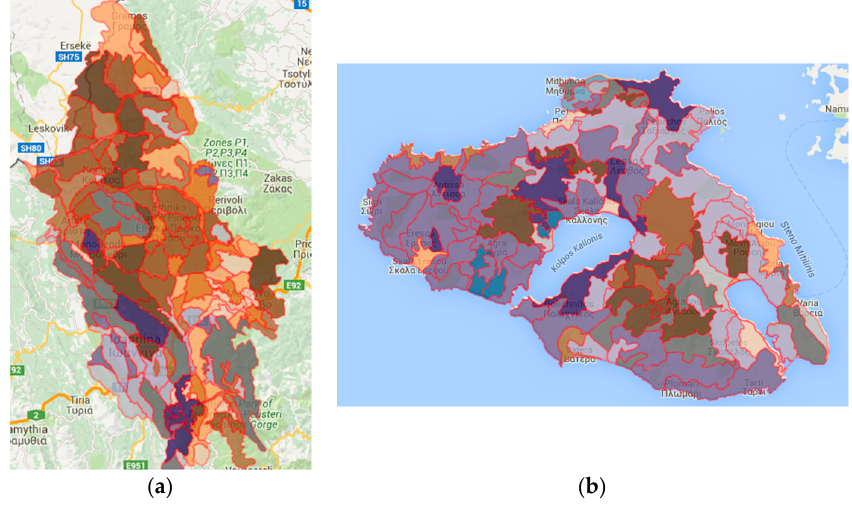
Figure 19. Landscape Risk Assessment (LRA) maps for the two areas in Greece: ( a , b ).